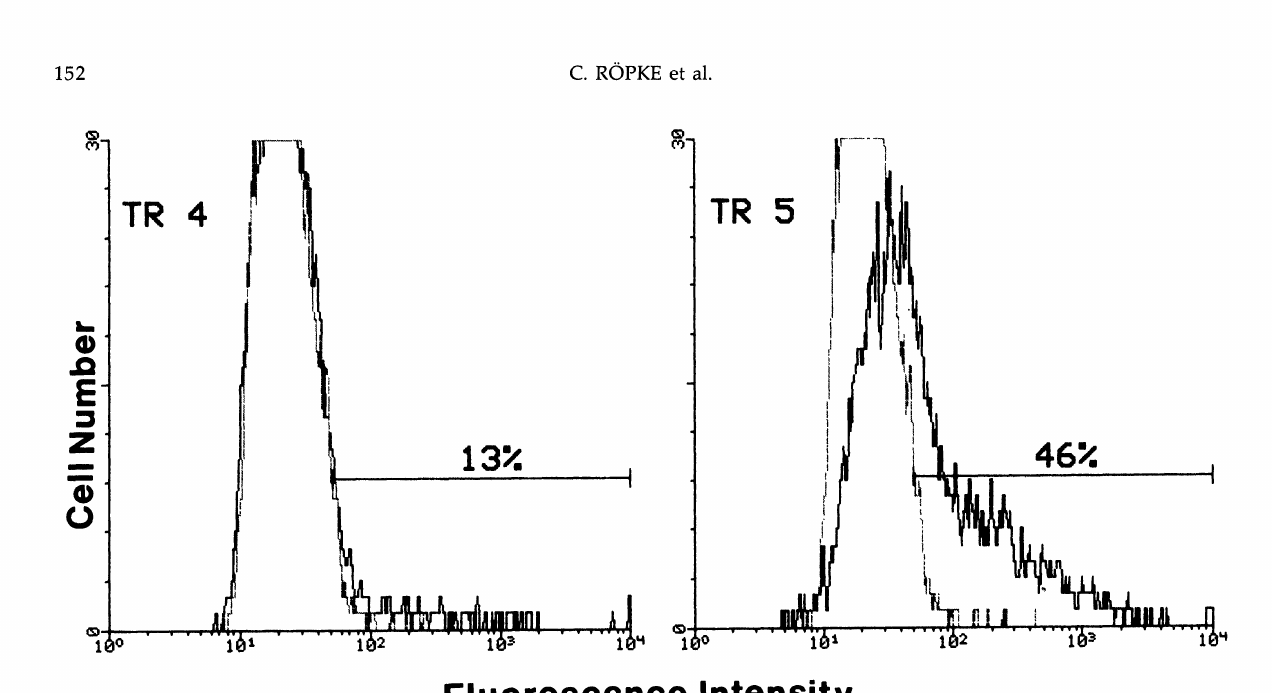
FIGURE 3. Histograms showing results from a typical experiment in which cultured thymic epithelial cells derived from a 15-day-old murine fetus were labeled with either RaRA-FITC (thin line), TR4 + RaRA-FITC for detection of cortical epithelial cells (TR4: heavy line), or TR5 + RaRA-FITC for detection of medullary epithelial cells (TR5: heavy